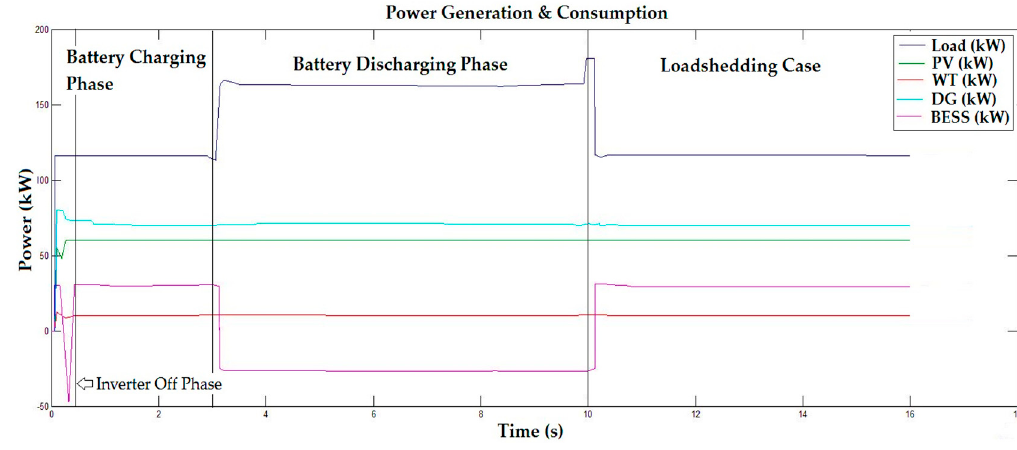
Figure 17 . System output characteristics in system overloading mode (load shedding).